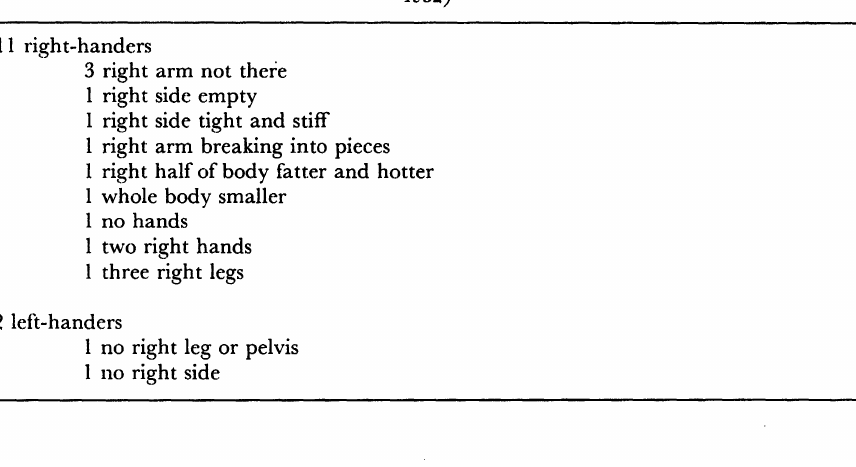
TABLE 3. Anomalous bodily experiences in 13 patients with left-sided lesions (Hecaen and Ajuriaguerra,